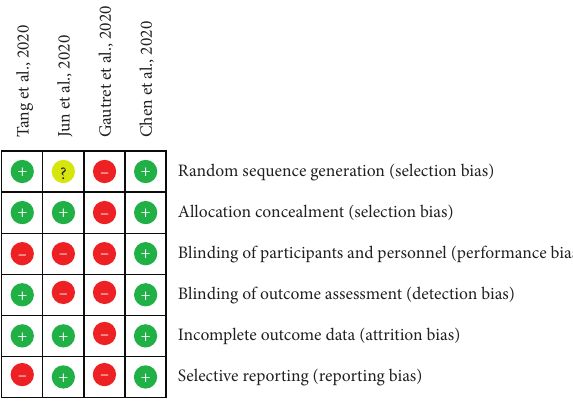
Figure 12: Risk of bias assessment for controlled clinical